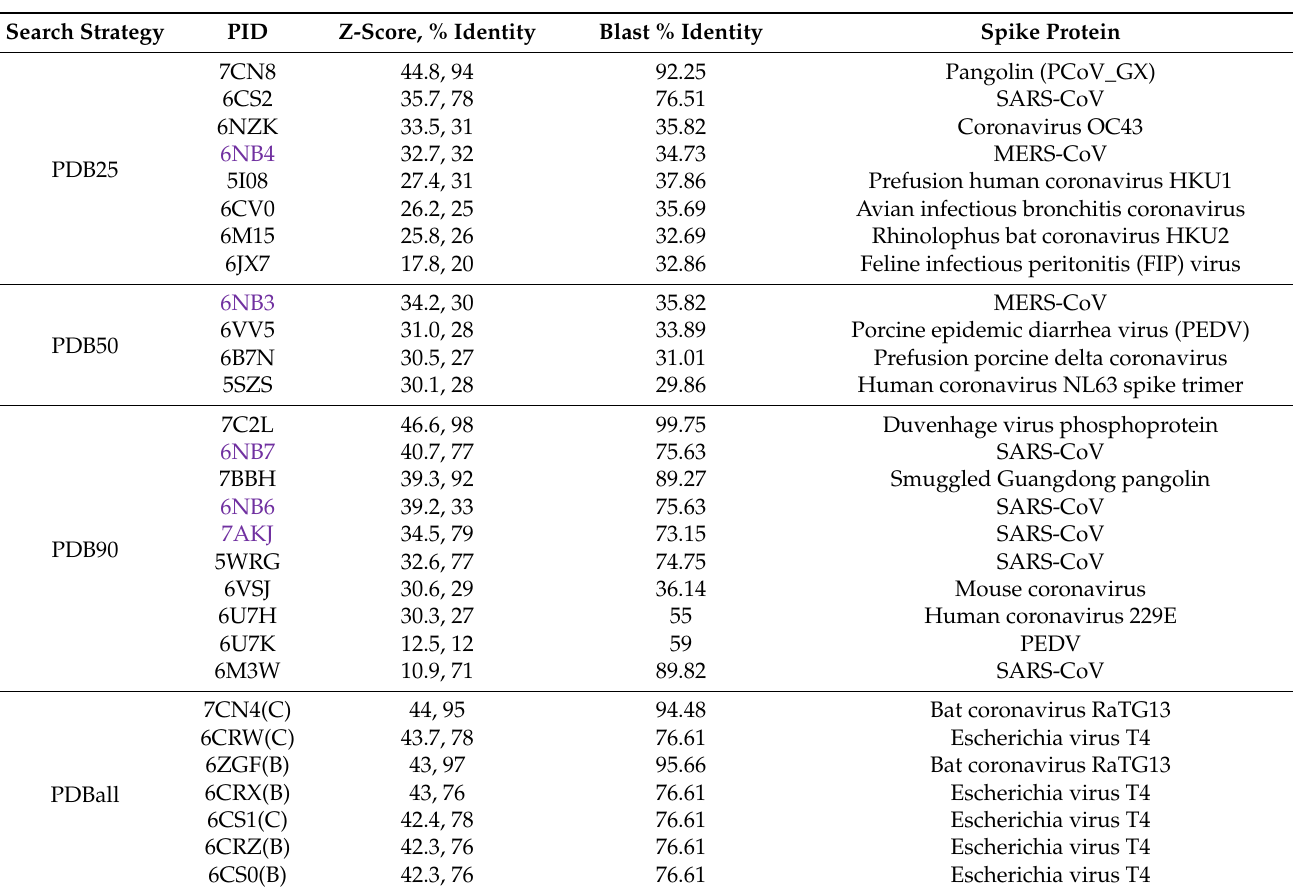
Table 3. Similar S protein structures of other viruses. Structures in complex with antibodies are highlighted in